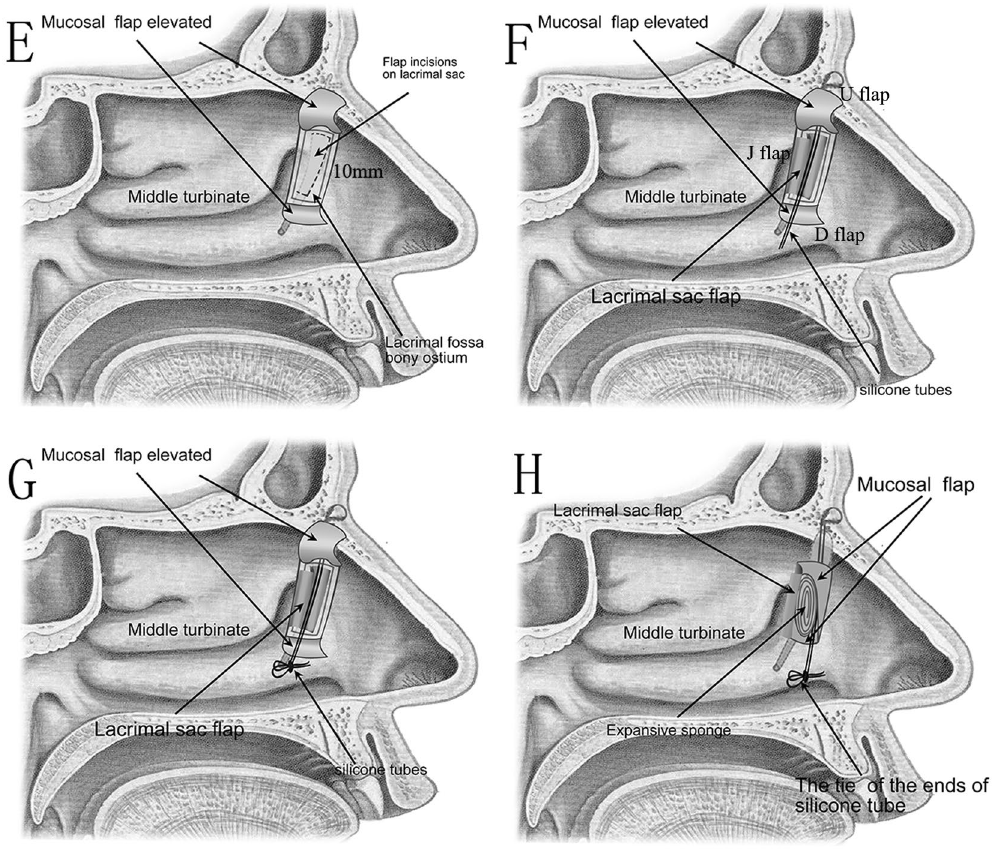
Figure 2. A Modified Preserved nasal and lacrimal mucosal flap Technique in Endoscopic Dacryocystorhinostomy. ( E ) Localization of the lacrimal sac flap incisions. ( F and G ) Lift up lacrimal sac flap, Silicone tubes are placed through lacrimal punctum after lacrimal flap is everted. ( H ) Mucosal flaps cover posterior, superior, anterior and inferior edge of the exposed bony ostium surface. Note the position of the expansive sponge, to maintain a patent